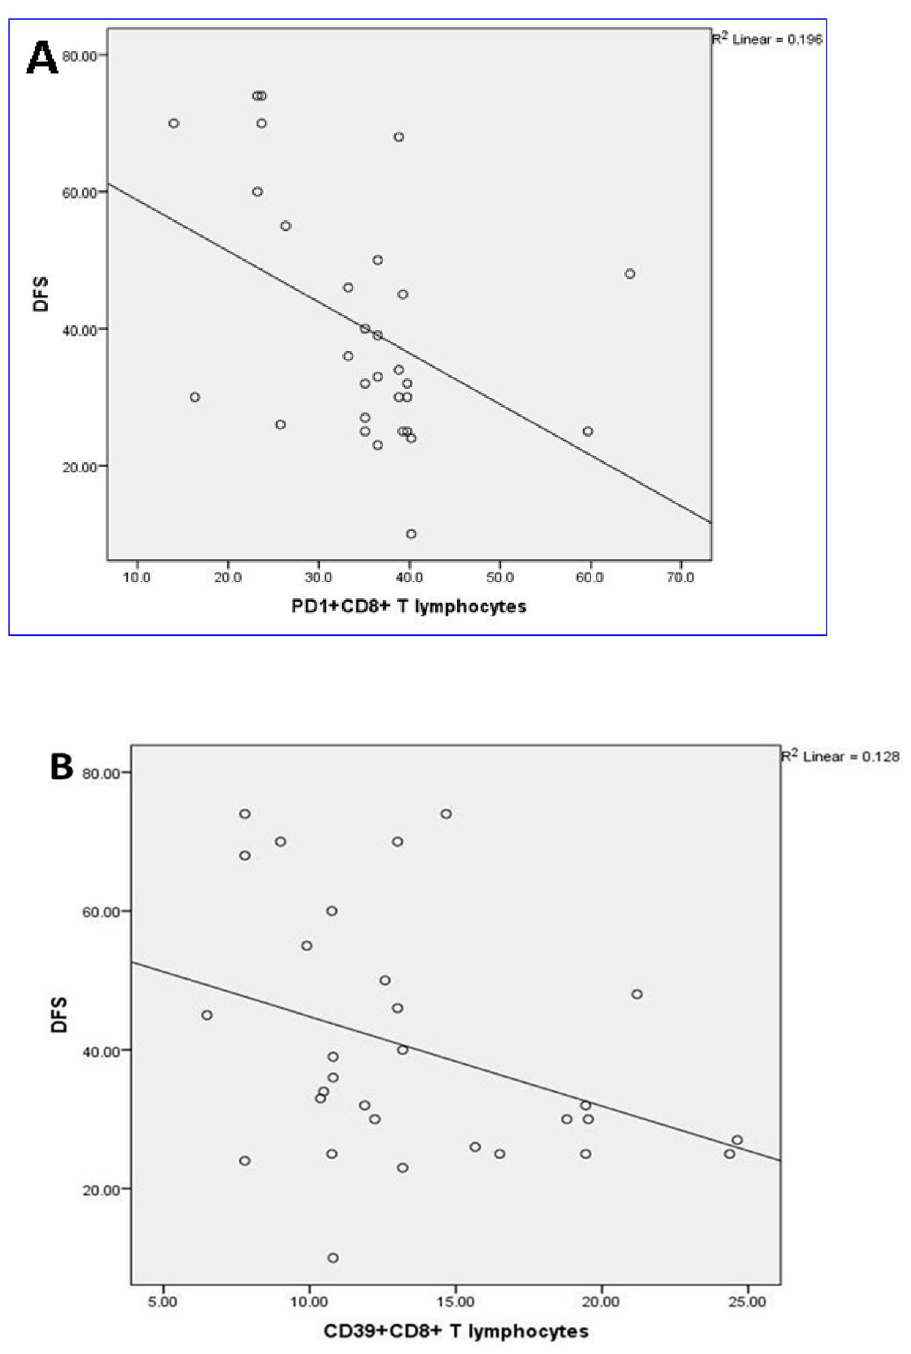
Fig 3. DFS association with tumor-infiltrating (A) PD1 + CD8 + T lymphocytes ( p = 0.007), and (B) CD39 + CD8 + T lymphocytes ( p = 0.03), in 30 TNBC patients.